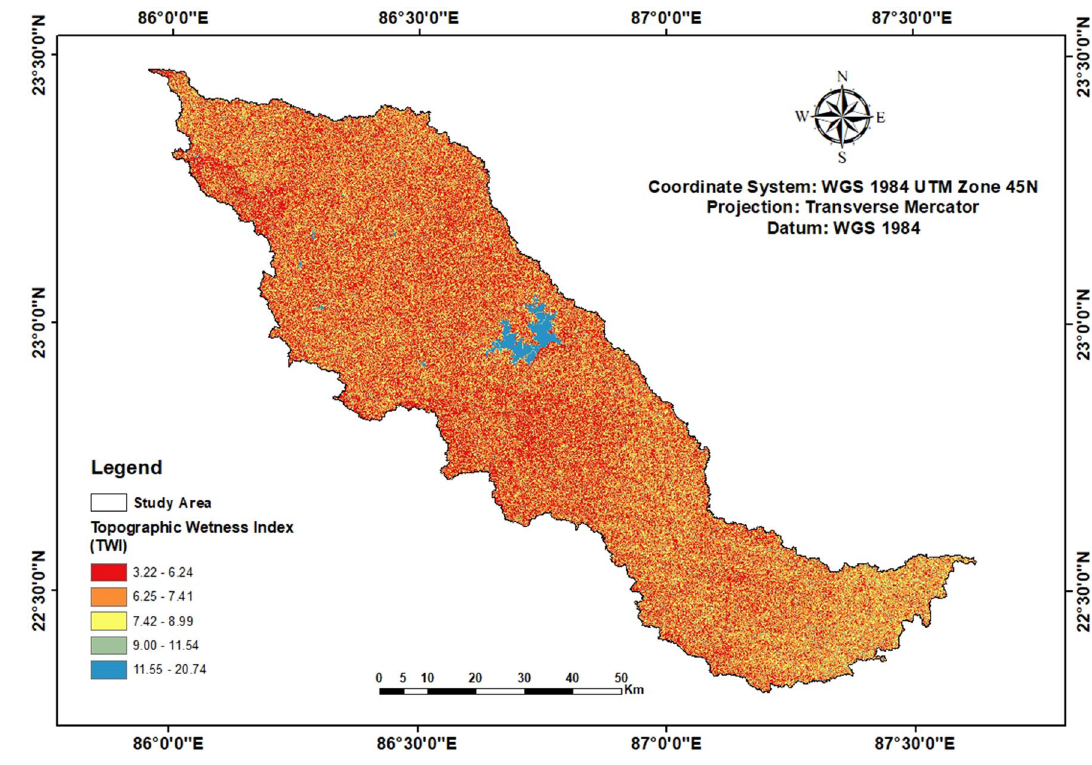
Fig. 13 Spatial distribution of topographic wetness index within Kangsabati River basin